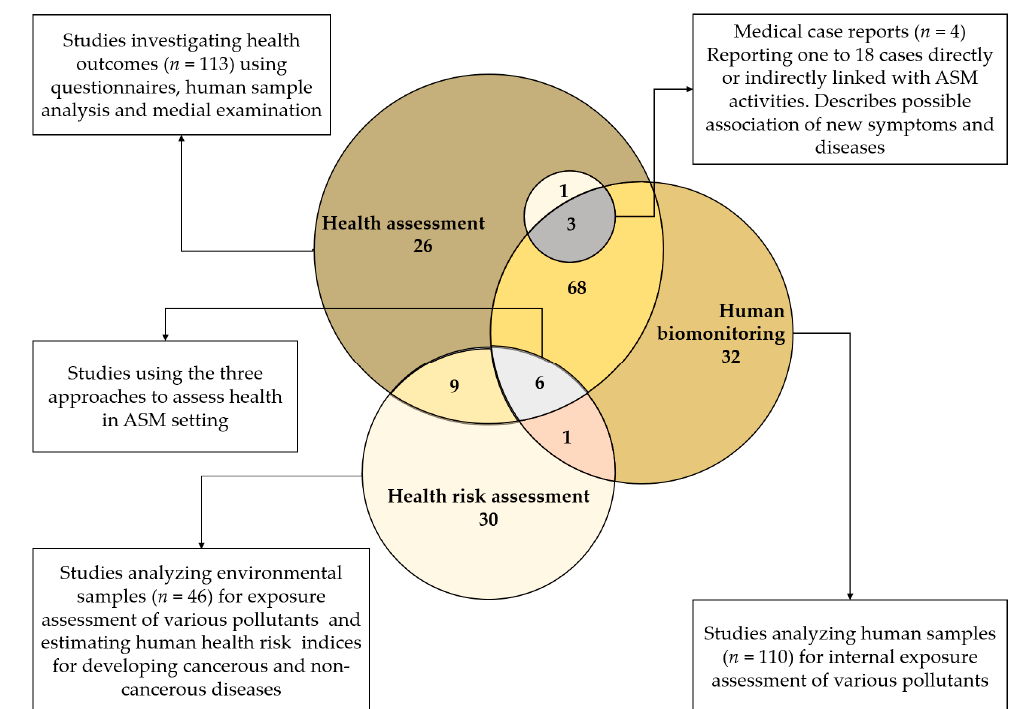
Figure 3. Overview of the characteristics of the 176 included health studies. Three main approaches for studying health were employed, including (i) health assessment (HA); (ii) human biomonitoring (HBM); and (iii) health risk assessment (HRA). Overlaps indicate studies for which more than one approach was used.